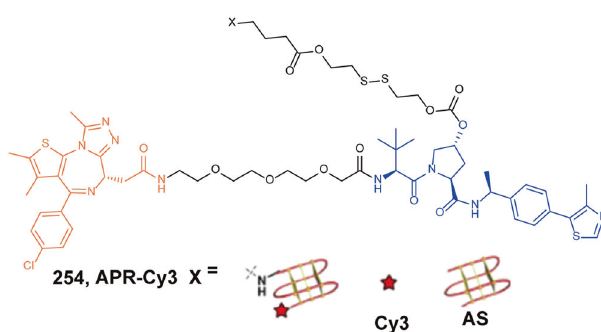
Fig. 83 The representative PROTACs of aptamer-PROTAC